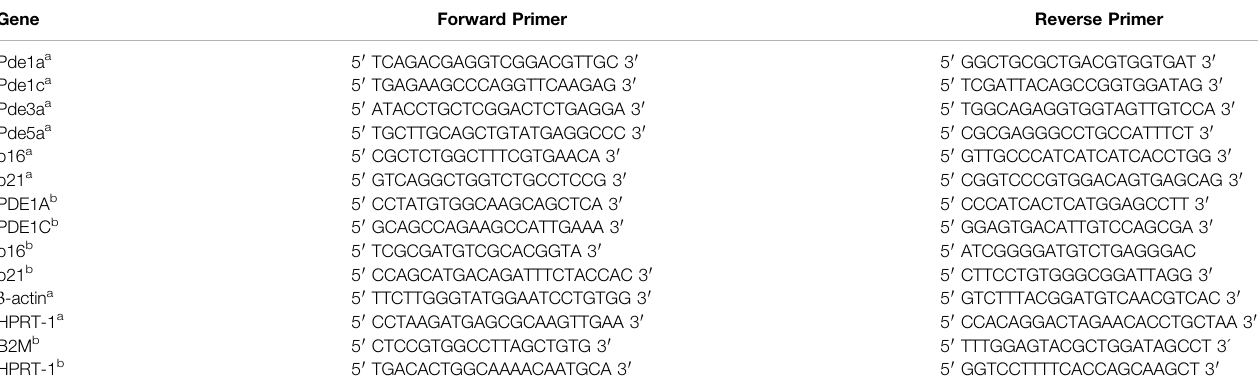
TABLE 1 | qRT-PCR